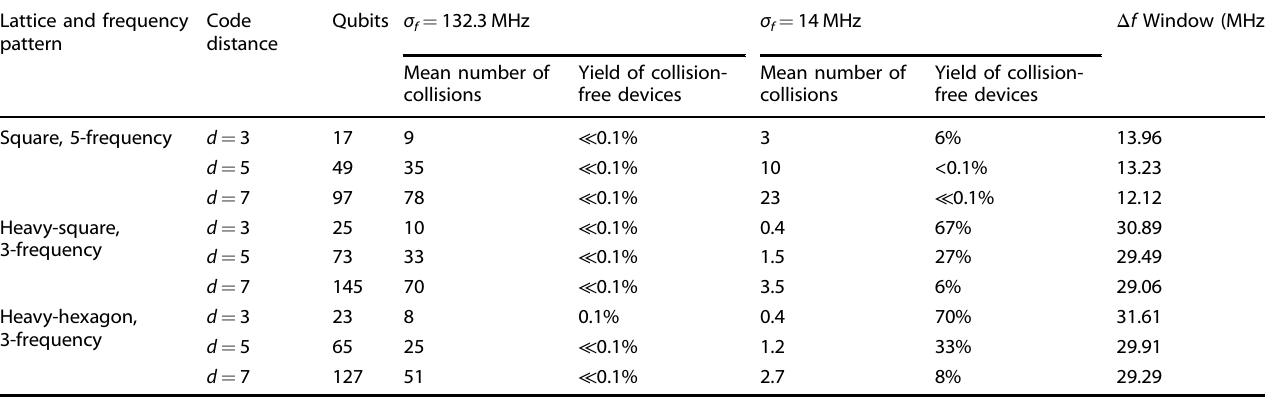
Table 2. Monte Carlo model predictions of the mean number of collisions and yield of collision-free chips. Lattice and frequency pattern